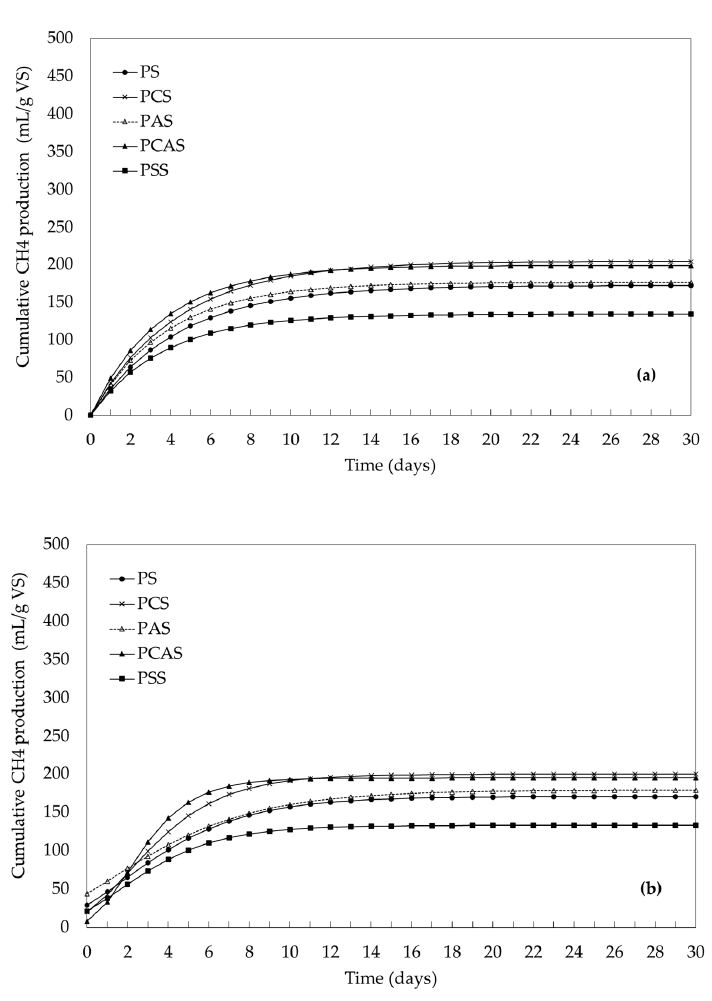
Figure 7. Kinetics modeling for SIR = 1:2 g VS substrate/g VS IN. ( a ) First order kinetics model; ( b ) modified Gompertz model.